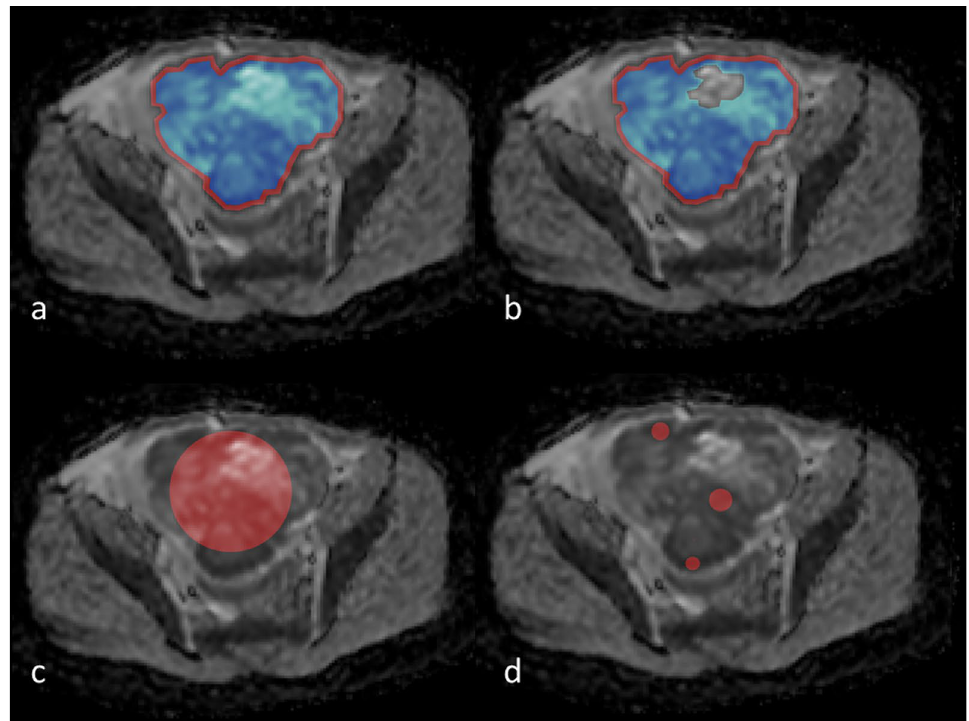
blue area. c ‘Circle’ strategy. +